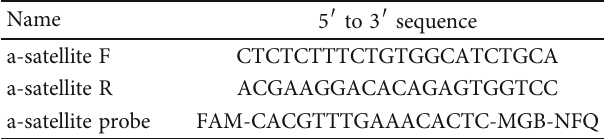
Table 2: Oligonucleotides and probes used for TaqMan qPCR.